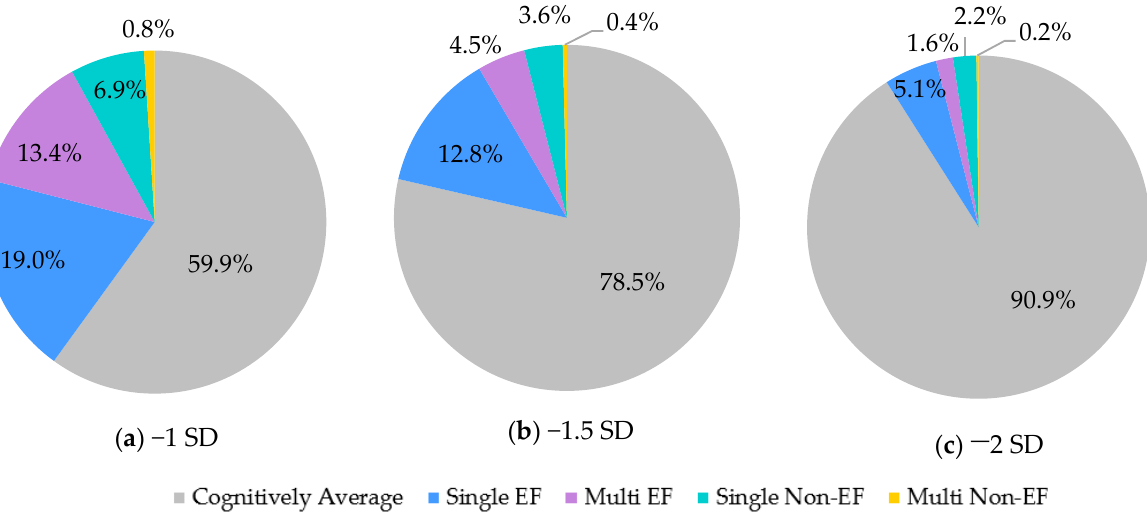
Figure 1. PD-MCI subtype breakdown by actuarial criteria cutoffs. ( a – c ) Depict the percentages of the sample that fall into each MCI subtype based on the respective SD cutoff. EF = Executive Func- tion.